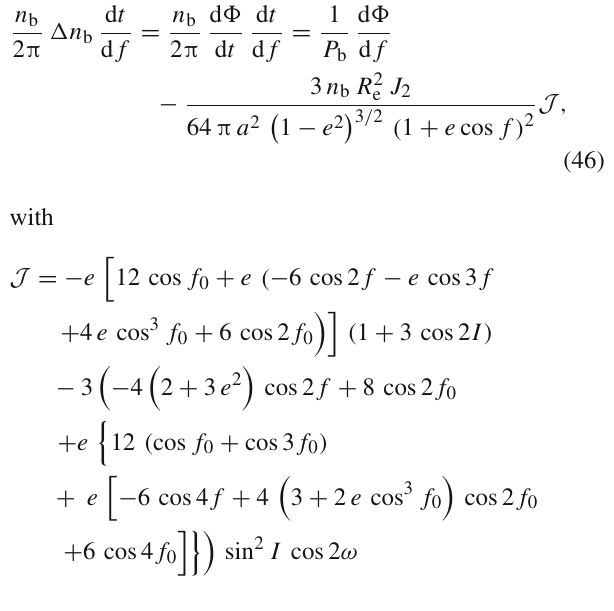
Fig. 2 Upper panel: plot of Eq. (46), computed for the orbital con- figuration of Table1 and with f 0 = 228 ◦ , over a full orbital cycle of (cid:14) (cid:15) · (cid:8) the true anomaly f . Its area, giving in mas year − 1 , turns out to be equal to 3 . 8 × 10 7 masyear − 1 . Lower panel: numerically produced timeseries,inmas,of (cid:8)( t ) over1yearobtainedbyintegratingtheequa- tions of motion in rectangular Cartesian coordinates for the fictitious Earth’s satellite of Table1. The Newtonian acceleration of Eq. (44) due to J 2 was added to the Newtonian monopole. As initial value for the true anomaly, f 0 = 228 ◦ was adopted. The slope of the linear trend amounts just to the area under the curve in the upper panel